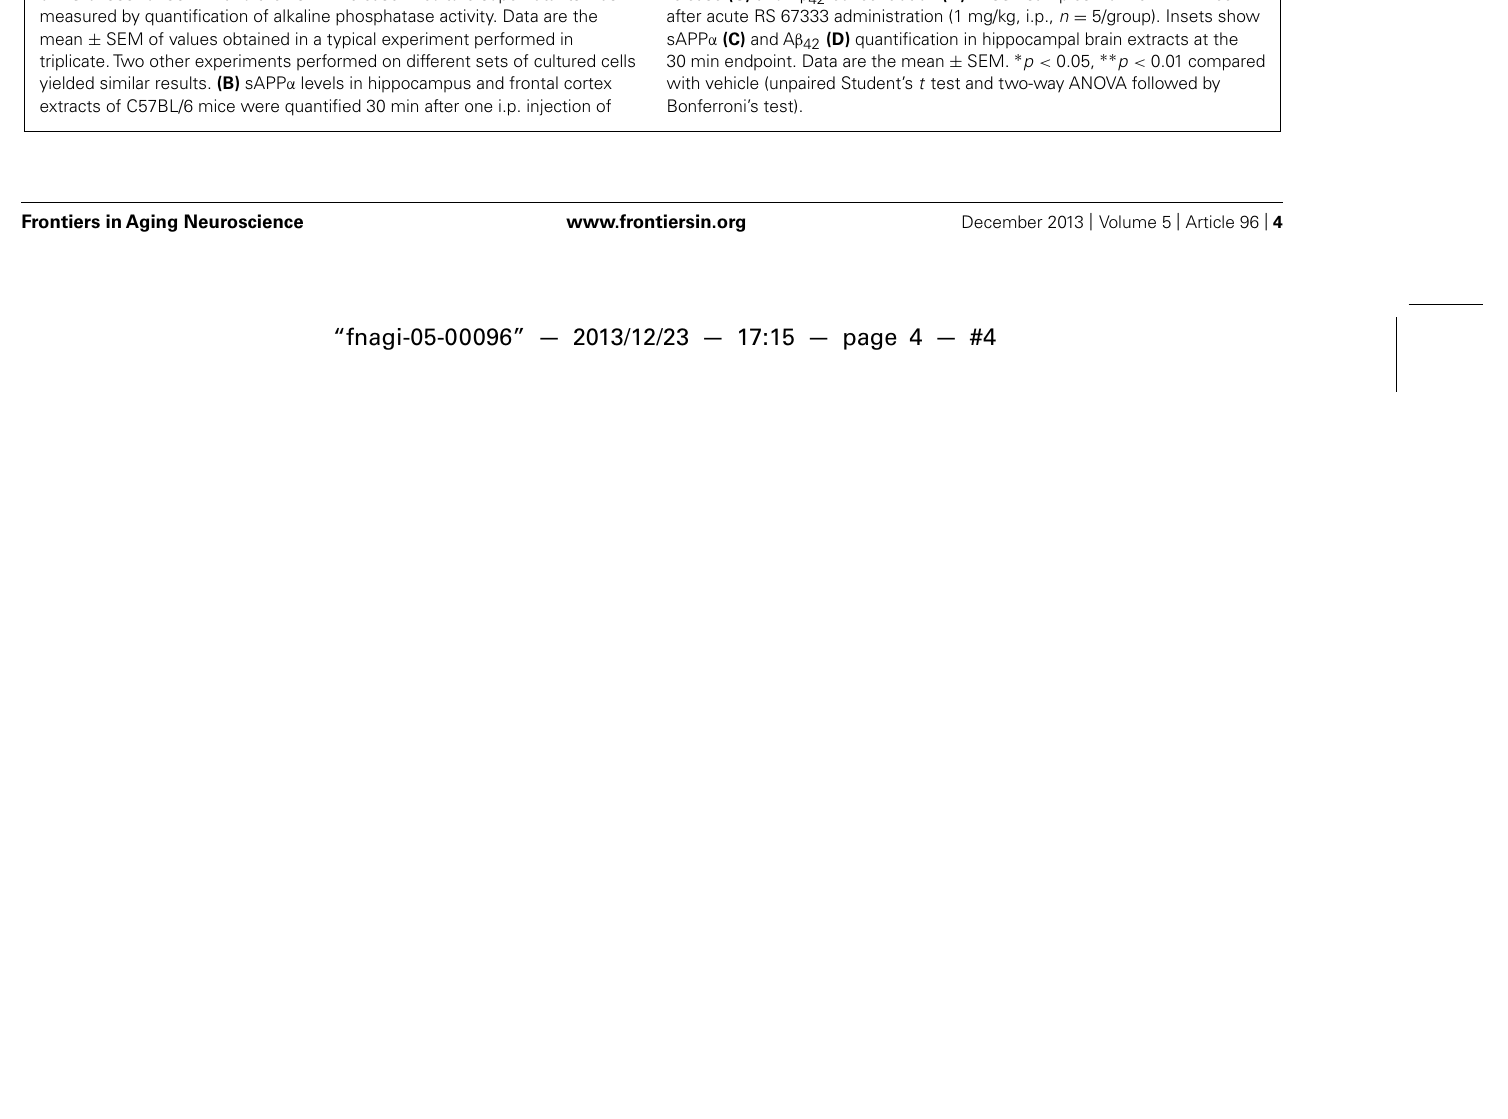
RS 67333 (1 mg/kg) and/or of the 5-HT 4 receptor antagonist RS 39604 (1 mg/kg, 15 min before RS 67333). sAPP α values are expressed in nanogram per milligram total proteins ( n = 6/group). (C,D) Kinetics analysis of sAPP α release (C) and A β 42 concentration (D) in CSF samples from 5XFAD mice after acute RS 67333 administration (1 mg/kg, i.p., n = 5/group). Insets show sAPP α (C) and A β 42 (D) quantification in hippocampal brain extracts at the 30 min endpoint. Data are the mean ± SEM. ∗ p < 0.05, ∗∗ p < 0.01 compared with vehicle (unpaired Student’s t test and two-way ANOVA followed by Bonferroni’s